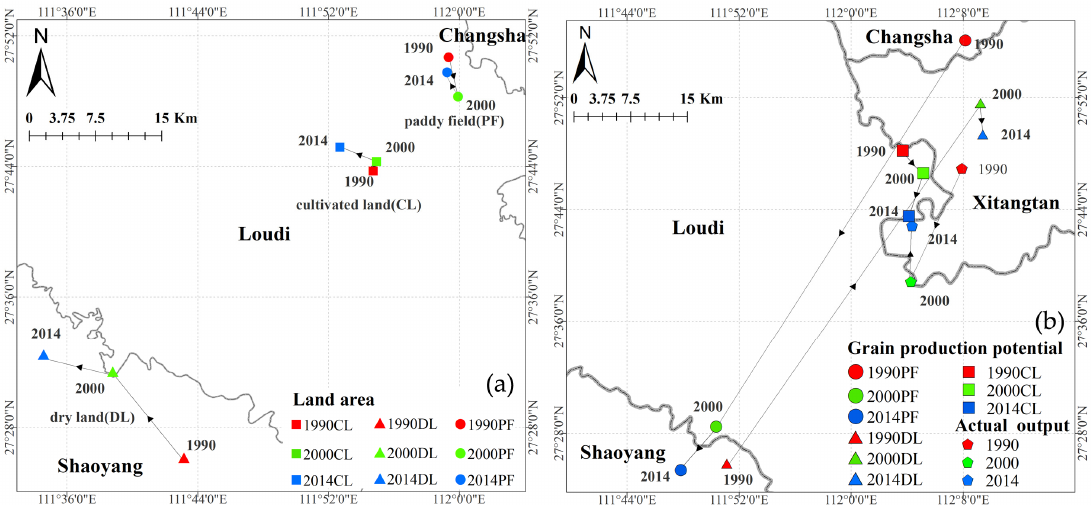
Figure 10. The movement of the barycenter of ( a ) cultivated land area and ( b ) grain production in Hunan Province from 1990 to 2014.